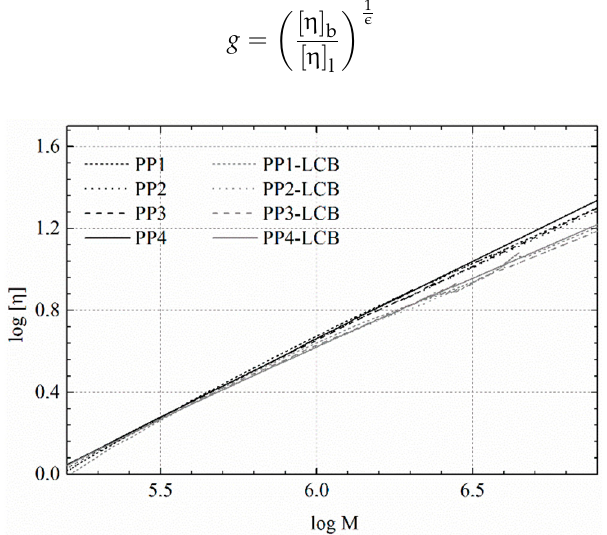
Figure 7. Intrinsic viscosity as a function of the molar mass of the linear PPs (black lines) and the LCB PPs (grey).